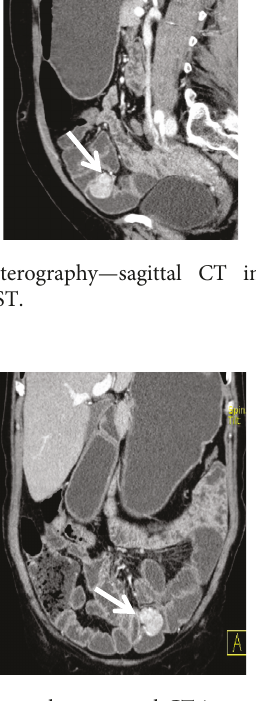
Figure 6: CT enterography — coronal CT image lesion compatible with GIST.